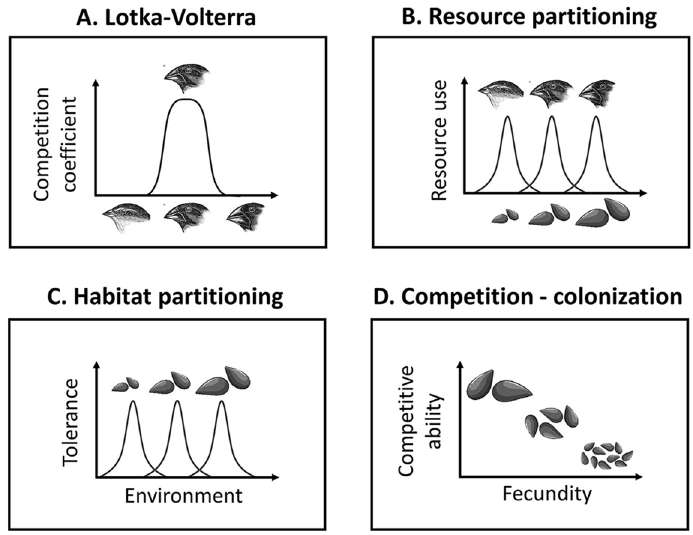
Fig 1. Schematic representation of niche models. Panel A illustrates Lotka-Volterra competition, while panels B-D illustrate different niche mechanisms, with the niche axis represented on the abscissa. A . Lotka-Volterra: competition coefficients are tied to traits, here beak size. Curve shows competitive impact by each species on the focal species, increasing with trait similarity. B . Partitioning resources: We assume a continuum of resources (seeds), and species traits (beak size) determine their use of the different resources. Depending on the degree of specialization, resource depletion may occur (see text). C . Partitioning environment: species with different traits (seed size) are optimally adapted to different environments. This model is spatially explicit, and we implement it both with and without dispersal limitation; D . Competition-colonization tradeoff: species trade off fecundity (seed output) with ability to win sites against other species (mediated by seed size). Seed icons adapted from design by